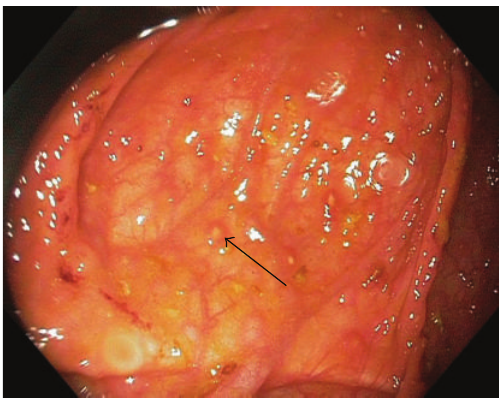
Figure 1: Multiple aphtous lesions (arrow) were found in the cecum and the ascending colon.